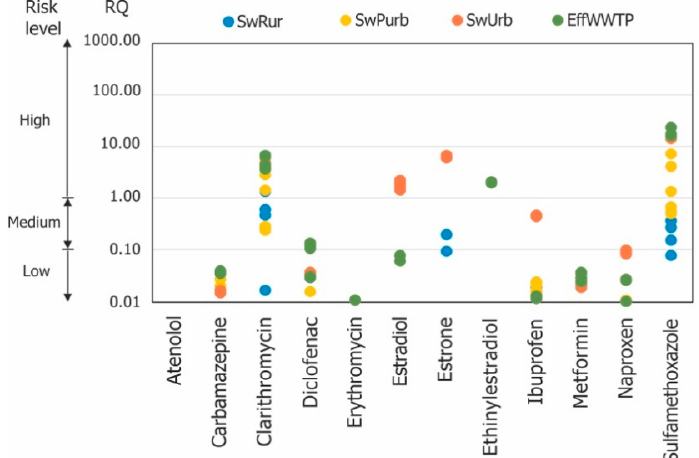
Figure 6. Risk posed by pharmaceuticals assessed by risk quotient (RQ) calculated as the ratio between measured concentration of pharmaceuticals (MEC) and the corresponding predicted no-effect concentration (PNEC) in SwRur, SwPurb, SwUrb, and EffWWTP (average of March and September campaigns) (SwRur: rural area; SwPurb: periurban area; SwUrb: urban area; EffWWTP: effluent of the wastewater treatment plant).